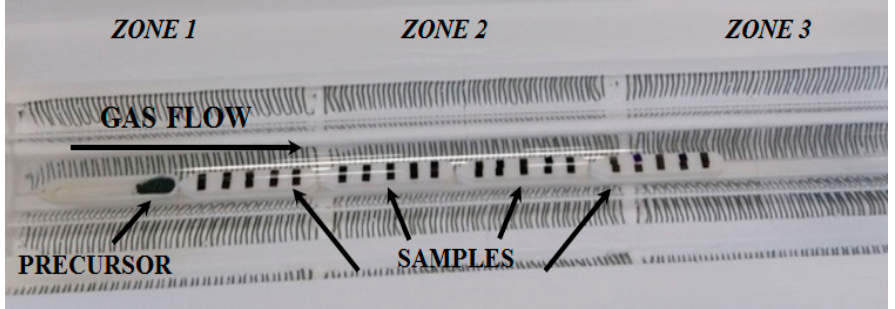
Figure 2. Image of the precursor and sample distribution inside the quartz tube where the synthesis experiments were carried out.